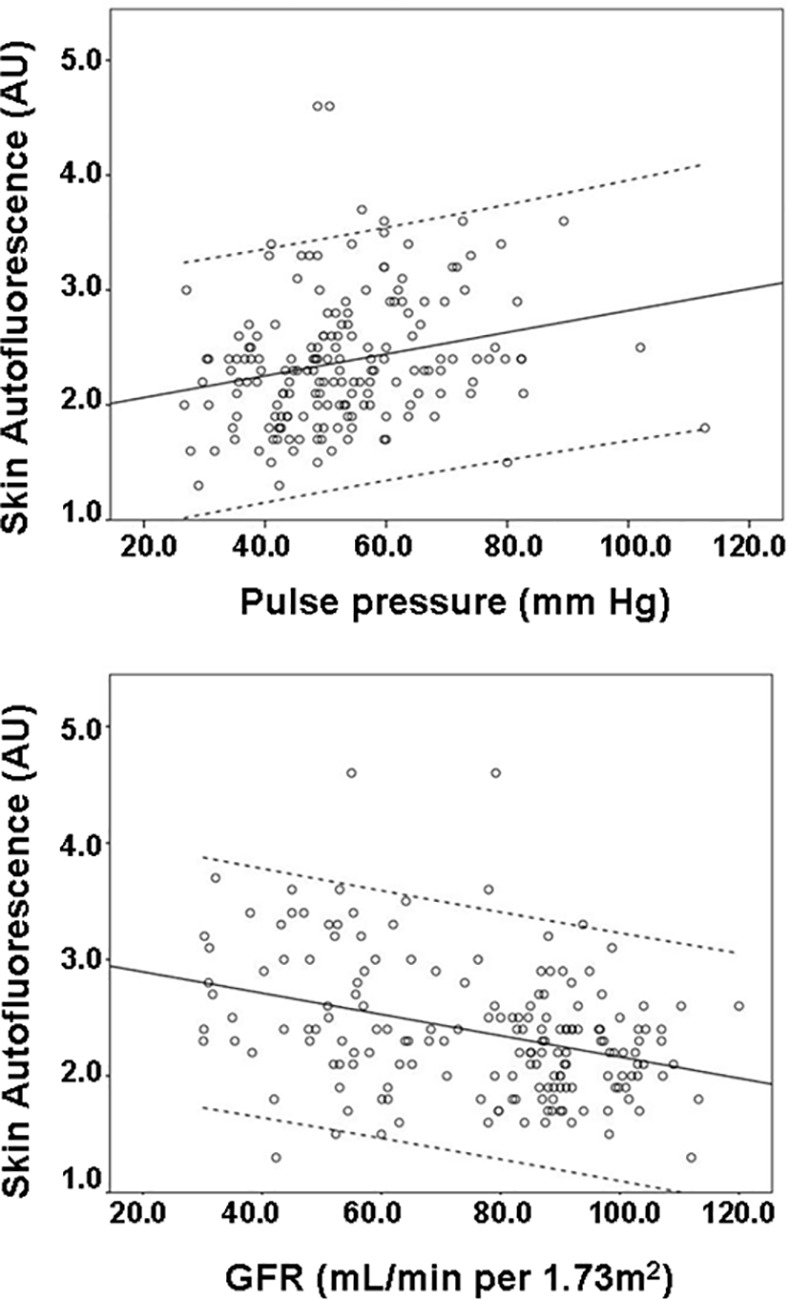
Scatter plot showing linear correlation between skin autofluorescence and: pulse pressure, and glomerular filtration rate.AU: arbitrary units; GFR: glomerular filtration rate estimated according the CKD-EPI (Chronic Kidney Disease Epidemiology Collaboration) equation.